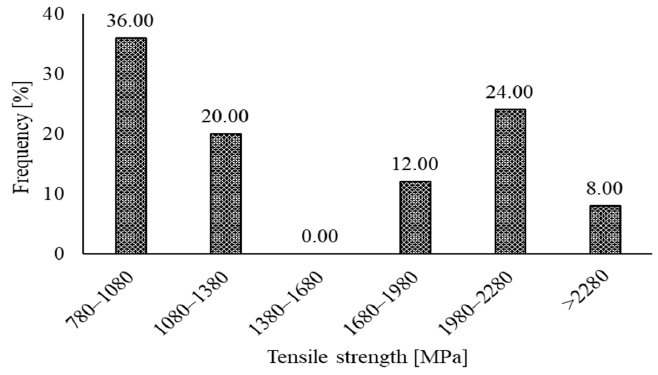
Figure 3. Frequencies of various tensile strengths of the RSFs.